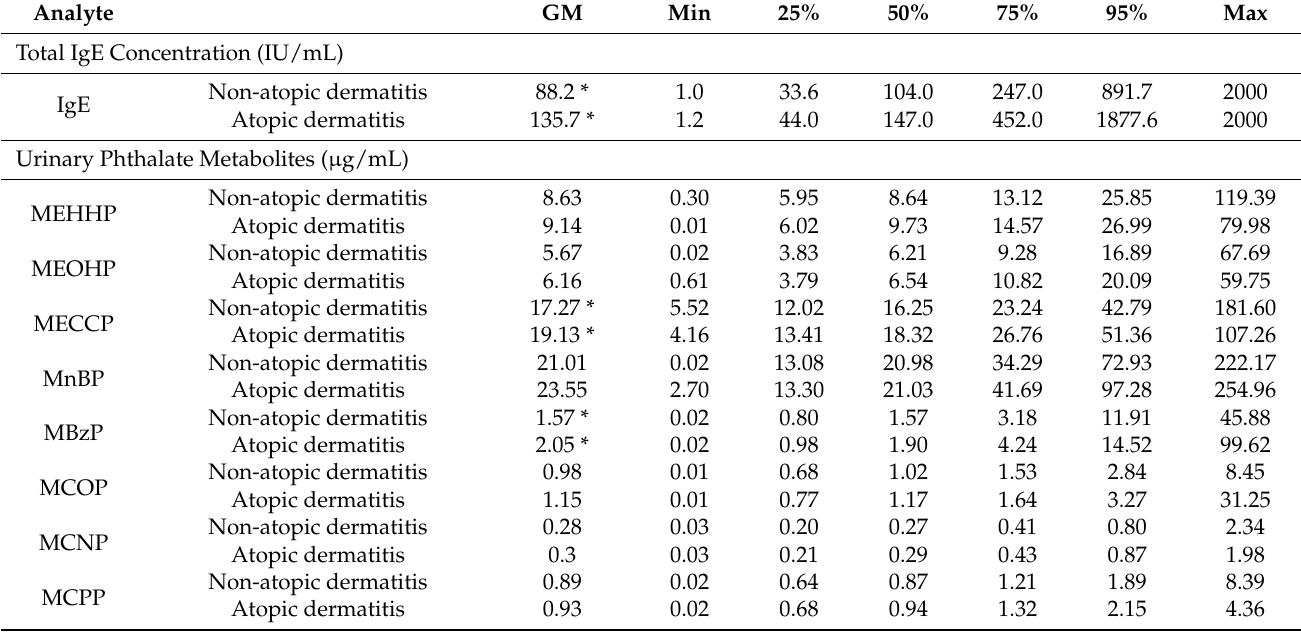
Table 3. Total Immunoglobulin E (IgE) and urinary creatinine-adjusted concentration of phthalate metabolite for the atopic dermatitis and non-atopic dermatitis groups.